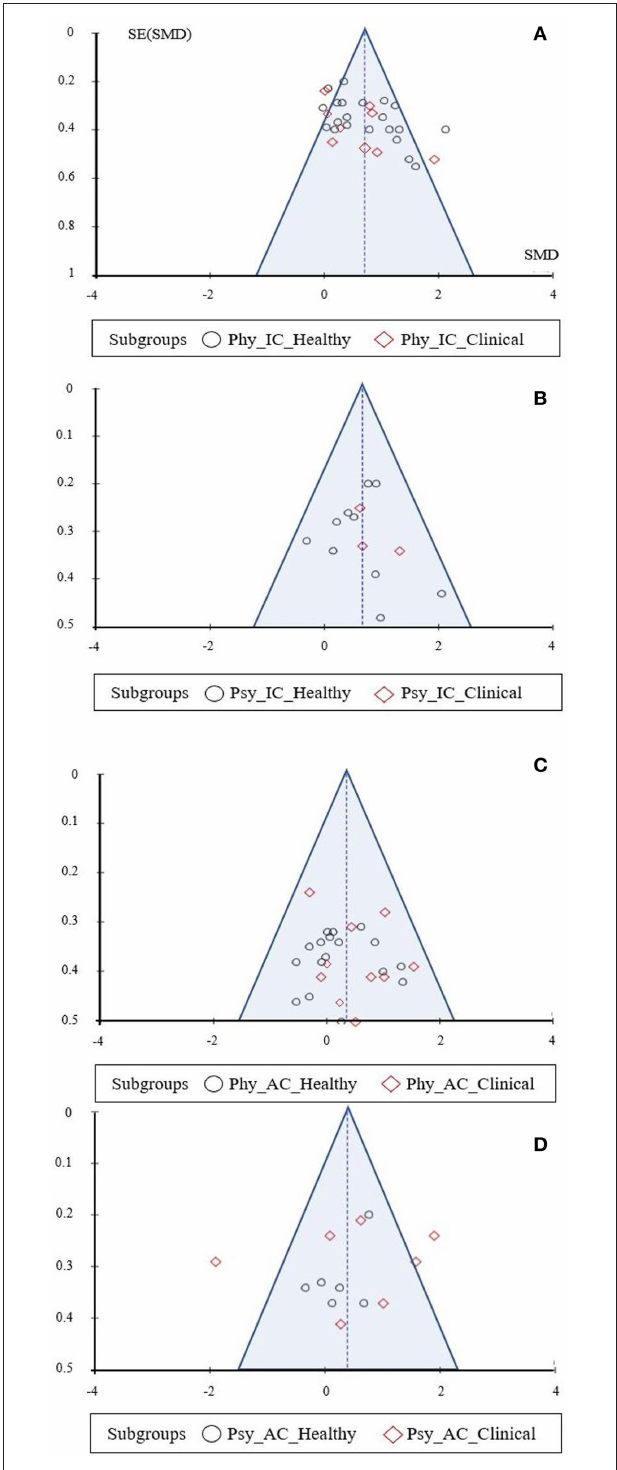
FIGURE 3 | Funnel plot: (A) clinical and non-clinical conditions - physiological health parameters: Pilates vs. IC; (B) clinical and non-clinical conditions - psychological health parameters: Pilates vs. IC; (C) clinical and non-clinical conditions - physiological health parameters: Pilates vs. AC; (D) clinical and non-clinical conditions - psychological health parameters: Pilates vs.